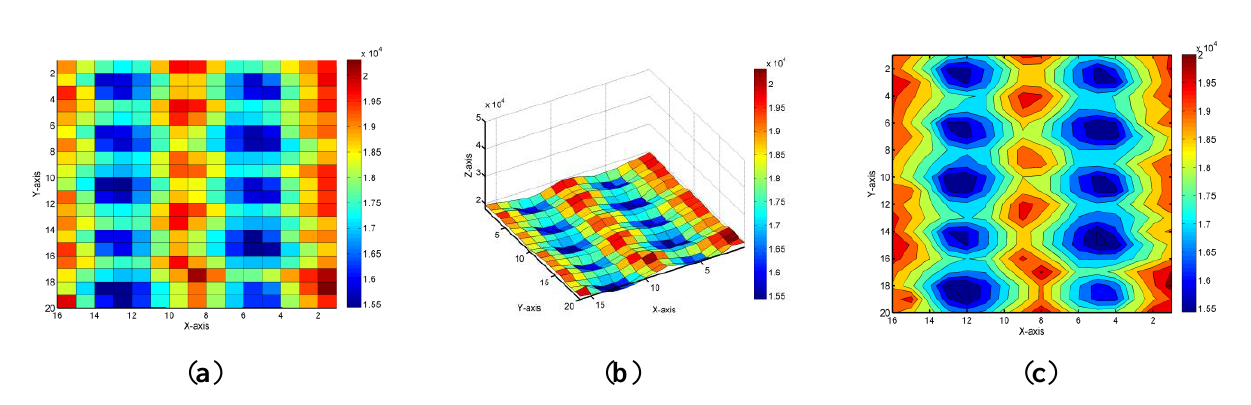
Figure 9. Primary capacitance values of the projected capacitance-sensing